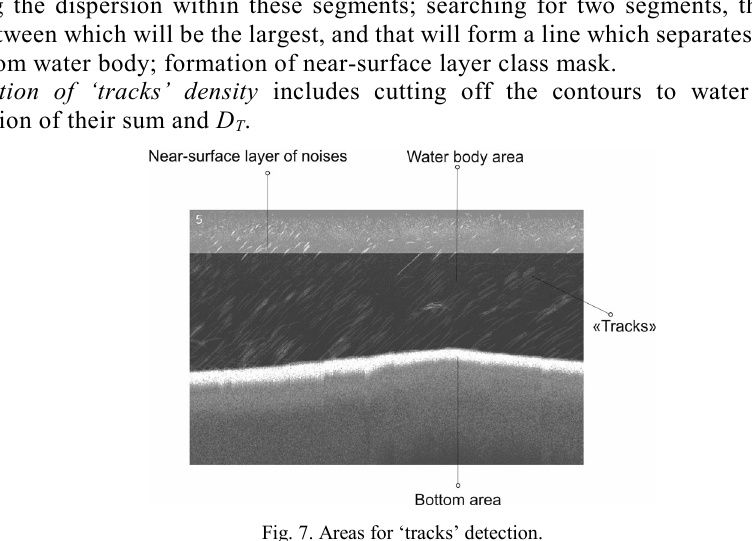
Fig. 7. Areas for ‘tracks’